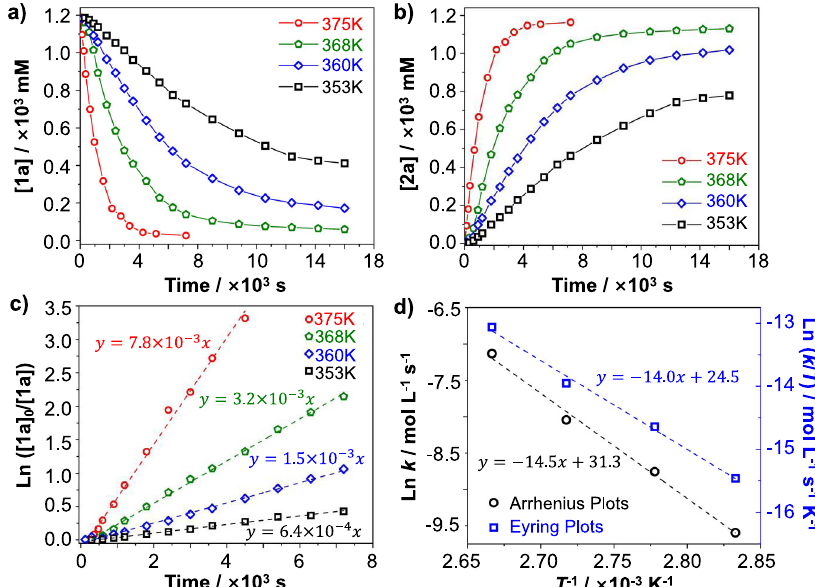
Fig. 3 Reaction kinetics. Reaction conditions: 1a (3.0 mg, 3.6 μ mol), CuBr 2 (4.0 equiv.), o -DCB (3.0 mL). a Concentration of 1a over time at different temperatures. b Concentration of 2a over time at different temperatures. c Plots of ln([ 1a ] 0 /[ 1a ]) over time at different temperatures, where [ 1a ] 0